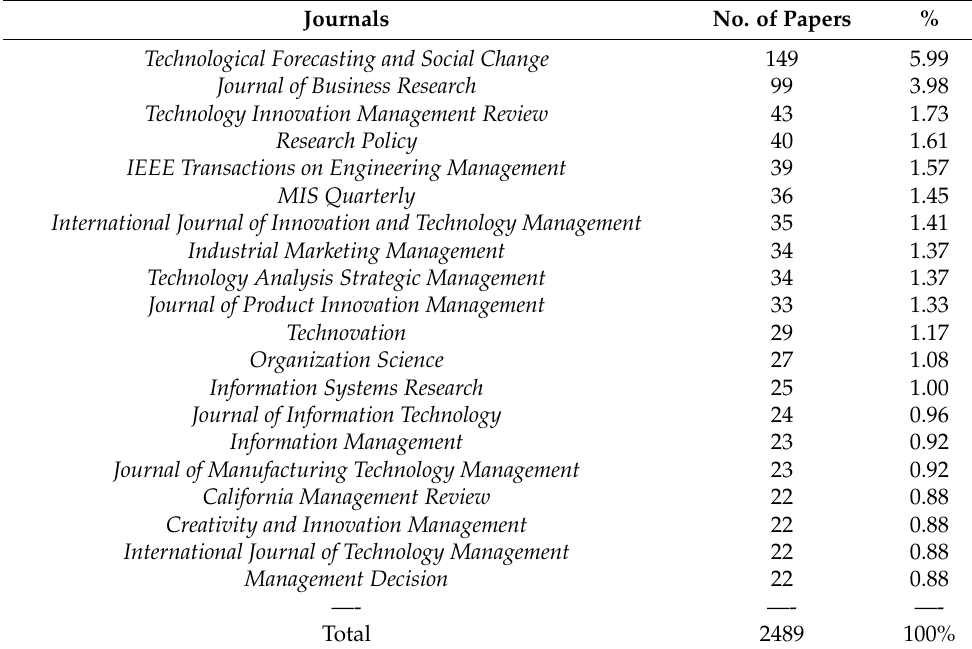
Table 1. Journals with twenty or more papers from 1994 to 2021.